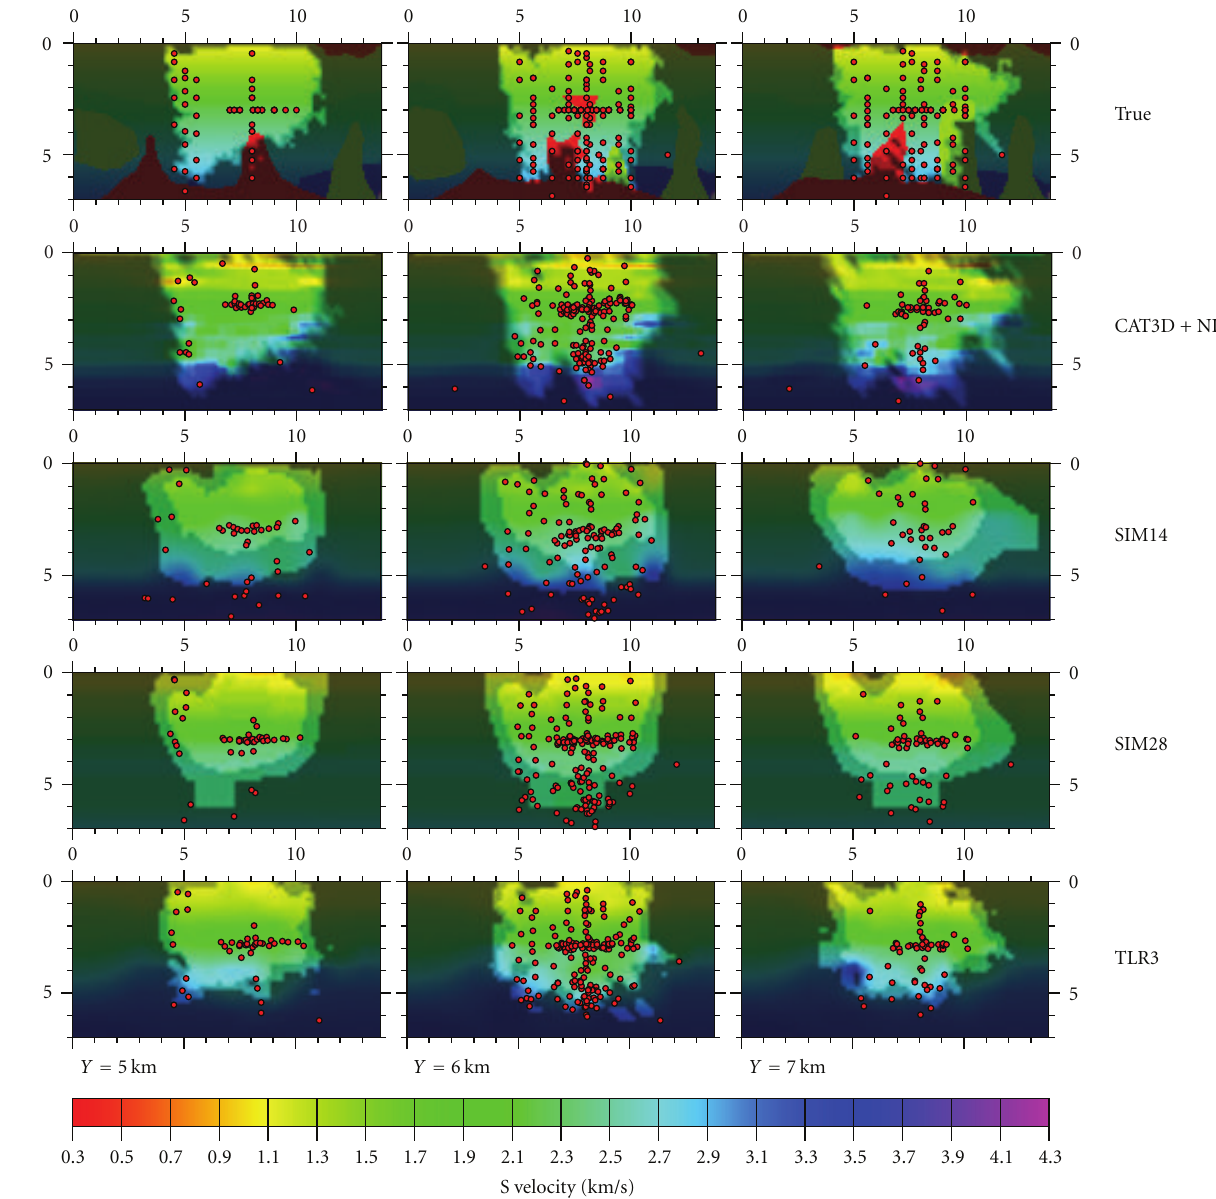
Figure 18: Same as Figure 16, in this case for V S